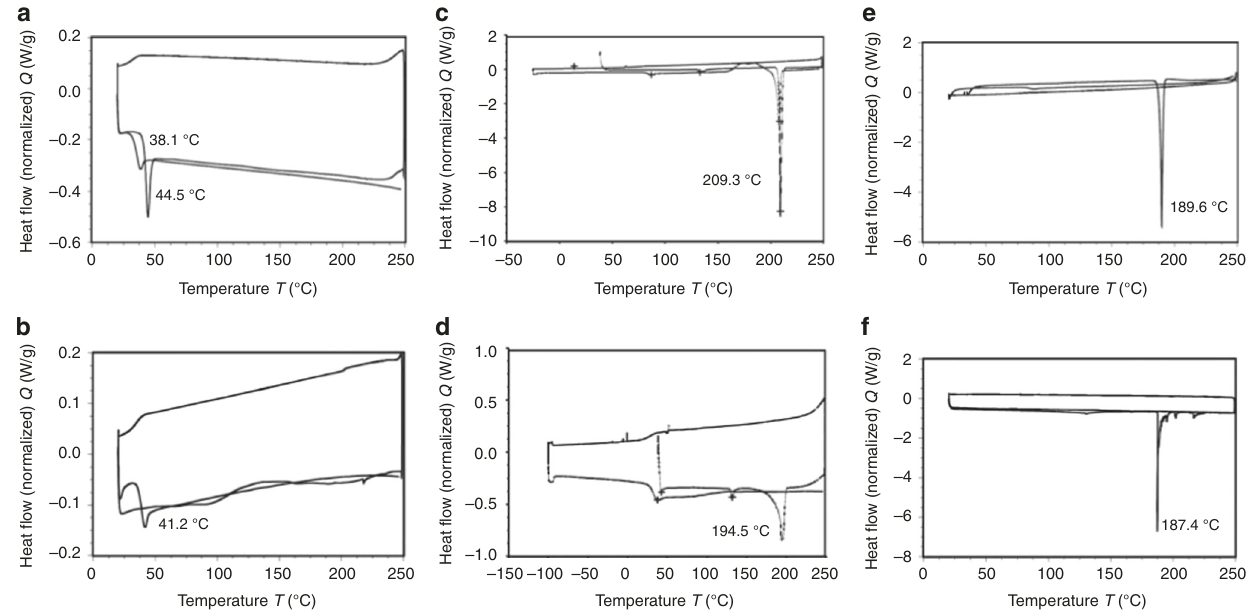
Fig. 1 Drug stability in ISFI formulation by DSC analysis. DSC thermograms: a PLGA (neat; 50:50 LA:GA, MW 27 kDa), b 1:2 PLGA/NMP Placebo ISFI, c MK-2048 (neat), d 0.9:1:2 MK-2048/PLGA/NMP ISFI, e DTG (neat), f 0.3:1:2 DTG/PLGA/NMP; the PLGA peak at ~40 – 50 °C is not visible due to scale relative to the strong DTG peak. Endodermic peaks with the respective glass transition and melting temperatures are indicated in each